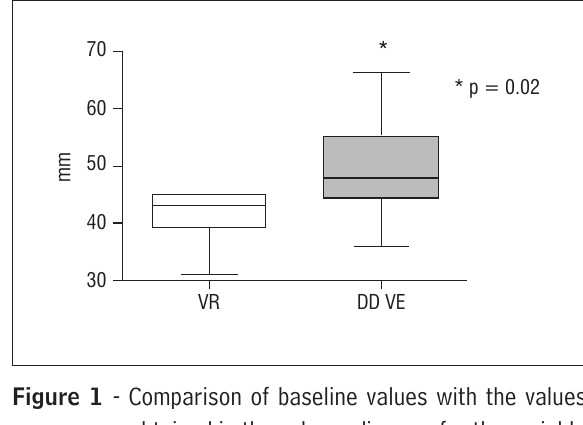
Figure 1 - Comparison of baseline values with the values obtained in the echocardiogram for the variable left ventricle diastolic diameter * (LVDD), where p = significance level